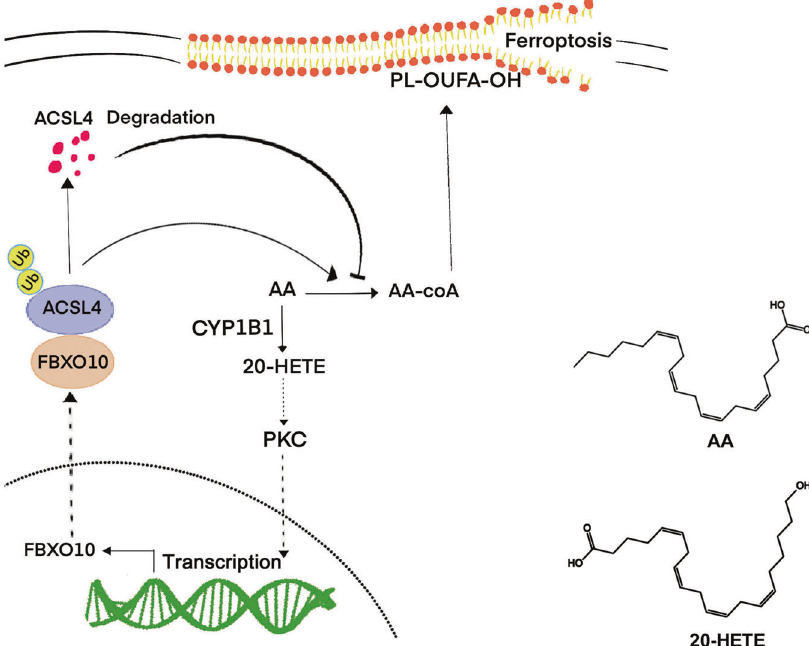
Fig. 6 Schematic diagram of CYP1B1 inducing ACSL4 degradation and inhibiting ferroptosis. Brie fl y, CYP1B1 metabolizes AA to 20-HETE to activate the PKC pathway, thereby increasing FBXO10 expression, which promotes ACSL4 degradation and leads to tumor cell resistance to ferroptosis. The lower right side shows the chemical structures of AA and